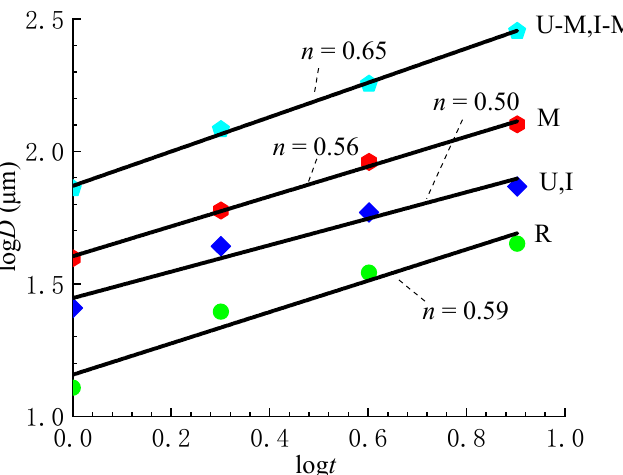
Figure 5. Double logarithmic plot of the corrosion depth vs. exposure time for carbon steel at some typical sites.